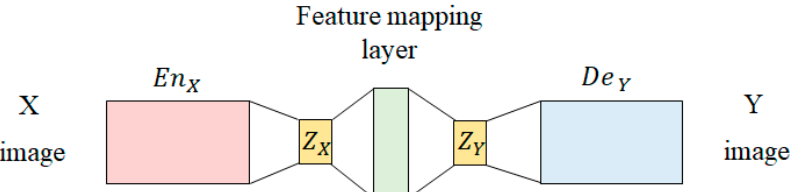
Figure 3. The concept of cross-connecting pre-trained autoencoders and decoders for feature space transfer (including a feature mapping layer).